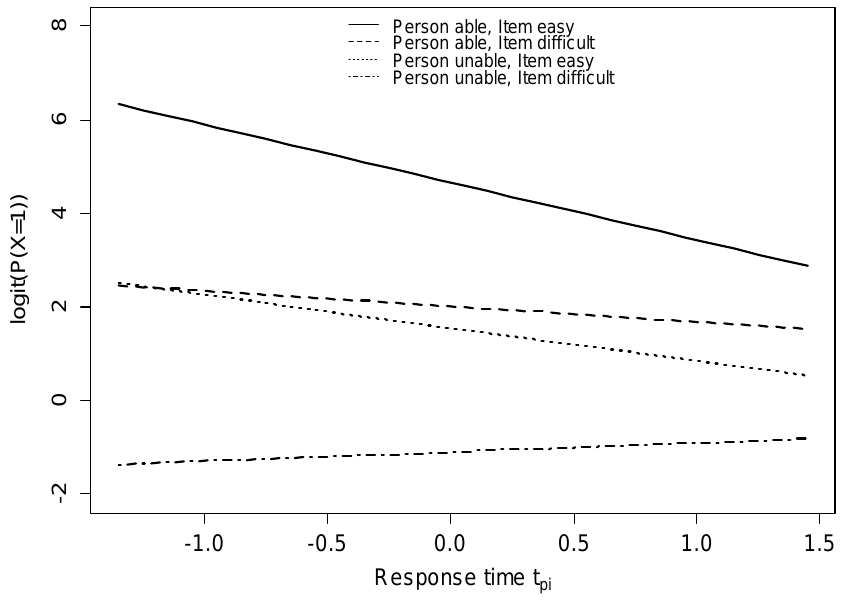
Figure 3. Item response time effect by item and person. For combinations of two items (easy vs. hard) with two persons (less able vs. able) the logit of the probability to obtain a correct response is plotted as a function of item response